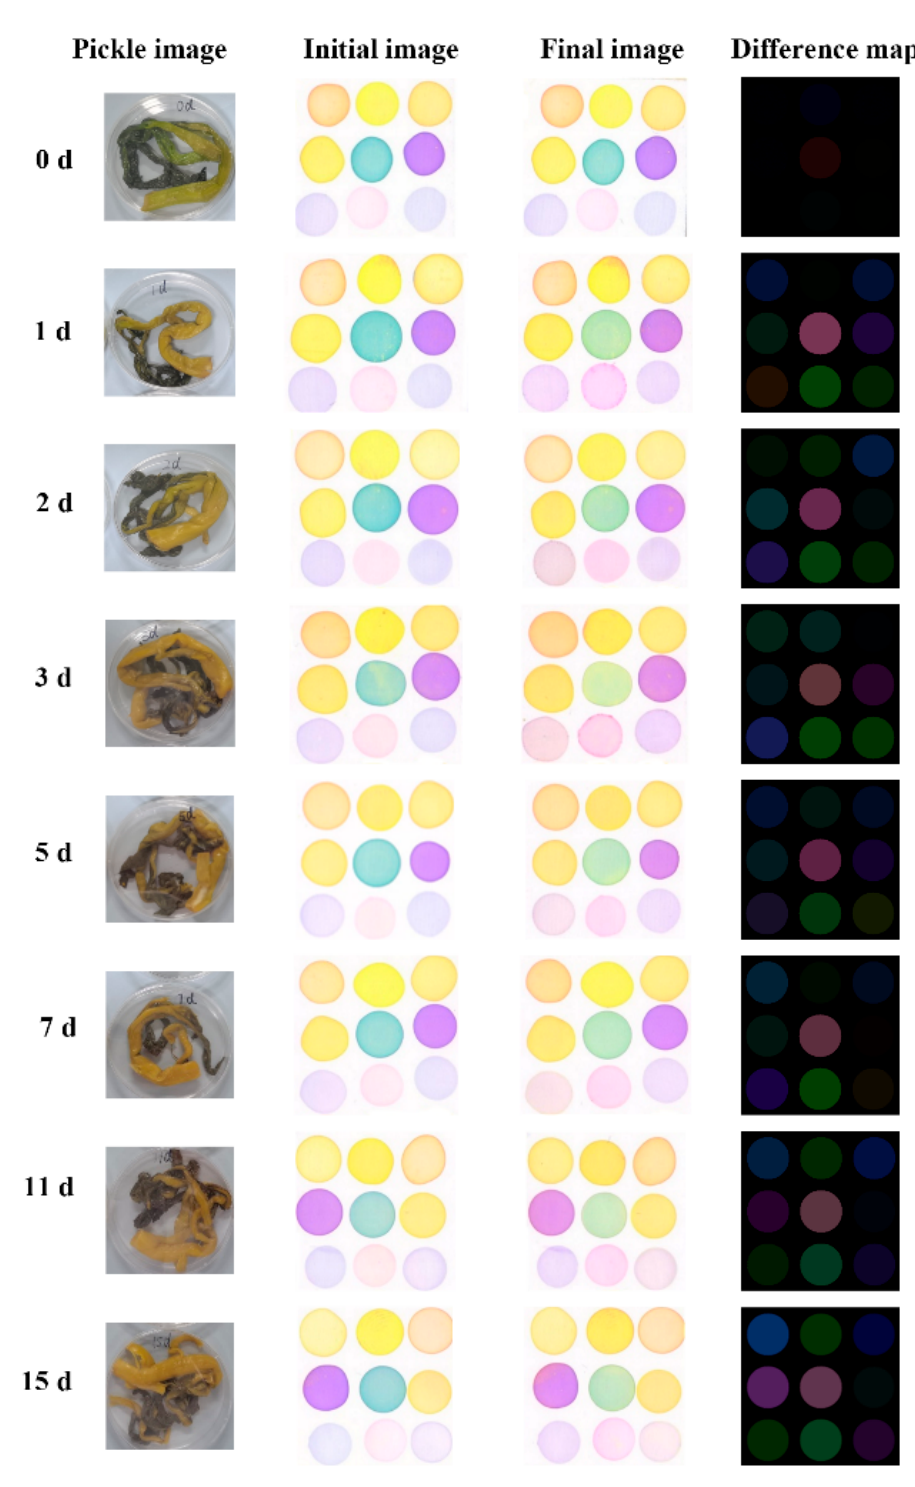
Figure 5. Images of CAS for pickles at different fermentation times.